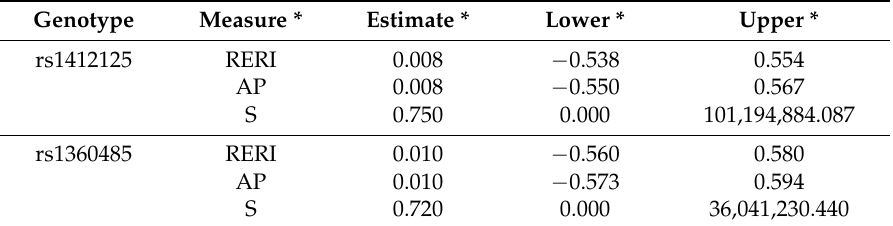
Table 6. Addictive interaction between SNPs and tobacco exposure in northeast Chinese population.